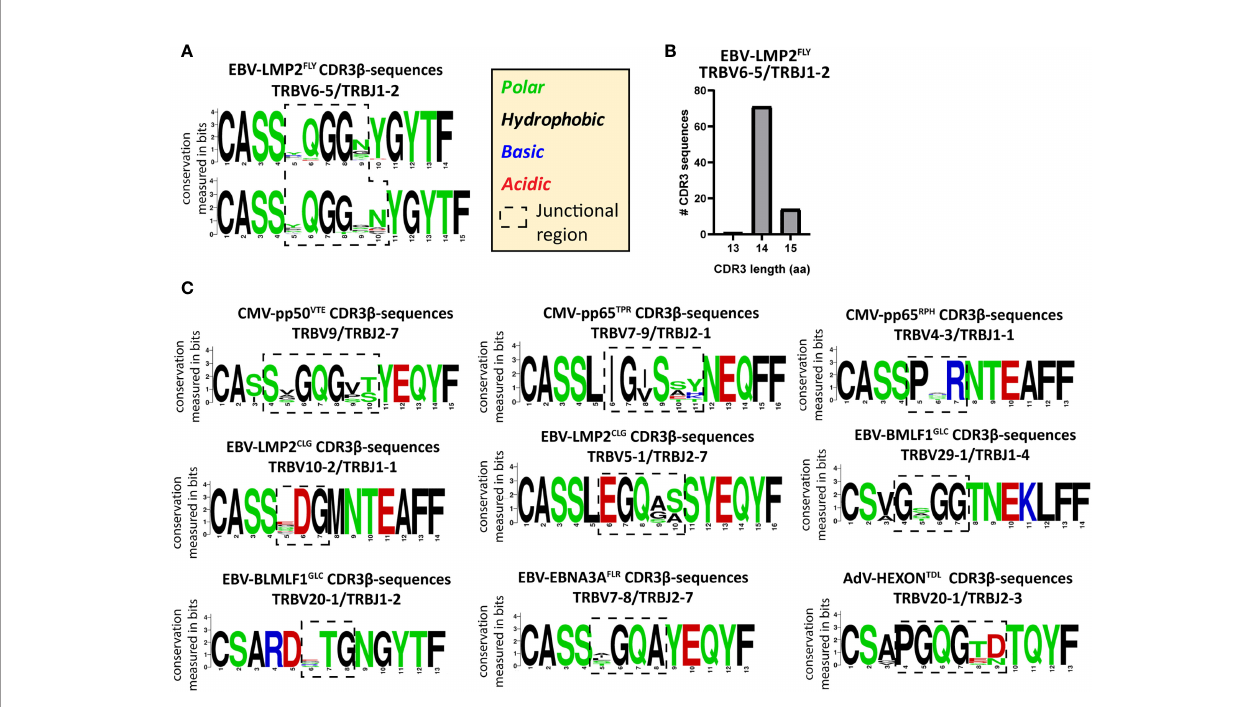
FIGURE 4 | PUB-HS CDR3 b AA-sequences show conserved regions and regions with high variability. The levenshtein distance was calculated (i.e. substitution, deletions or insertions of AAs) between CDR3 b AA-sequences that express the same TRBV/TRBJ-genes as the PUB-I CDR3 b AA-sequence. PUB-HS CDR3 b AA- sequences were included with 1, 2 and 3 AA-differences compared to the PUB-I CDR3 b AA-sequence. Sequence logos generated using WebLogo (http://weblogo. berkeley.edu/logo.cgi) show the relative frequency of each AA at each given position. The junctional regions (AAs that do not align with the germline TRBV or TRBJ- gene) are shown within the dotted-line box. (A) The CDR3 b AA-sequences speci fi c for HLA-A*02:01-restricted EBV-LMP2 FLY with a CDR3 length of 14 and 15 AAs were stacked and show conserved and variable regions in the CDR3 b -region. (B) Shown are the CDR3 length distributions of CDR3 b AA-sequences speci fi c for EBV-LMP2 FLY -expressing TRBV6-5/TRBJ1-2. (C) Shown are representative examples of PUB-HS (1, 2 or 3 AA differences) and PUB-I CDR3 b AA-sequences that were stacked per speci fi city and